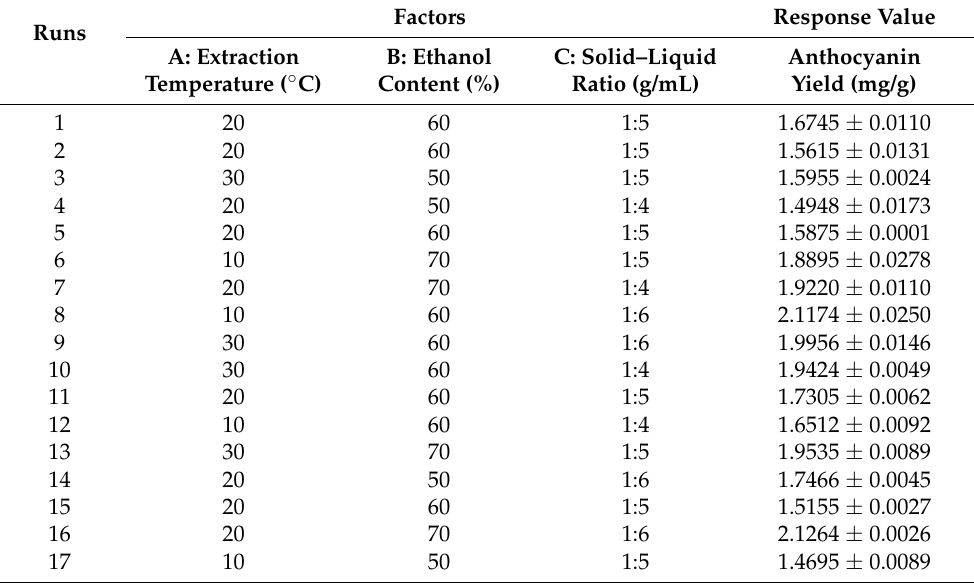
Table A1. The Box–Behnken design and the results of the response surface methodology.